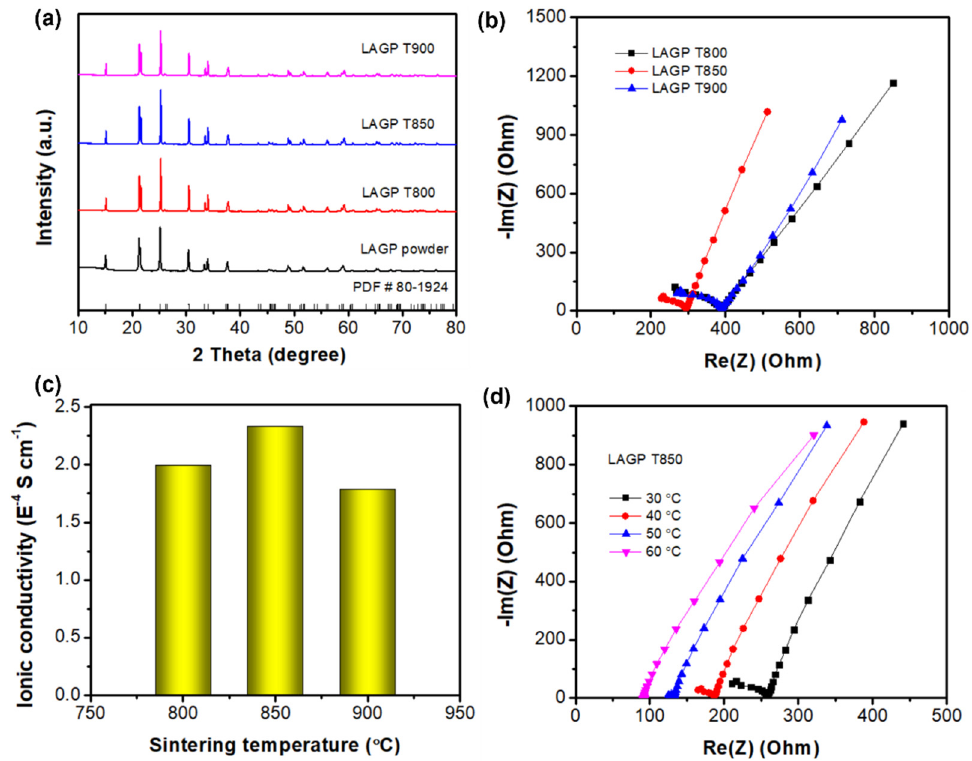
Figure 2. ( a ) XRD patterns, ( b ) Nyquist plots, ( c ) ionic conductivities of LAGP T800, LAGP T850, and LAGP T900 pellets, ( d ) Nyquist plots of LAGP T850 at 30–60 °C.